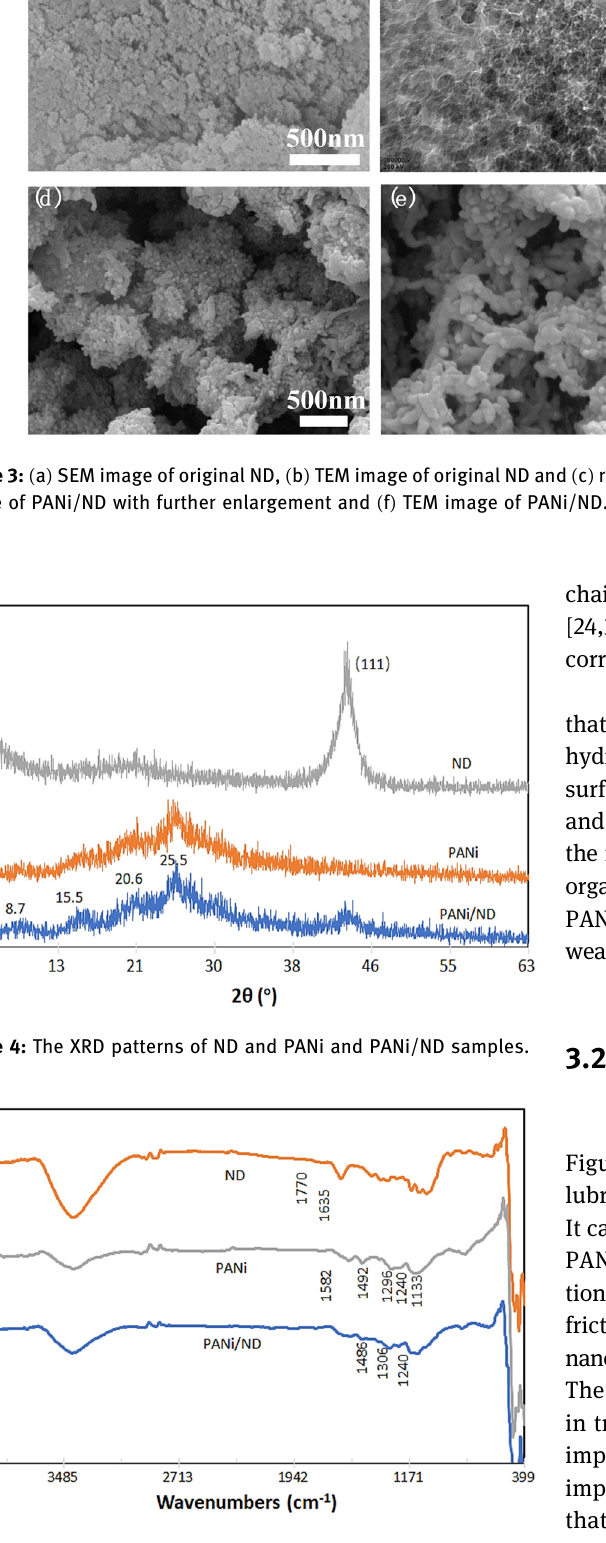
Figure 5: The FTIR patterns of ND and PANi and PANi/ND